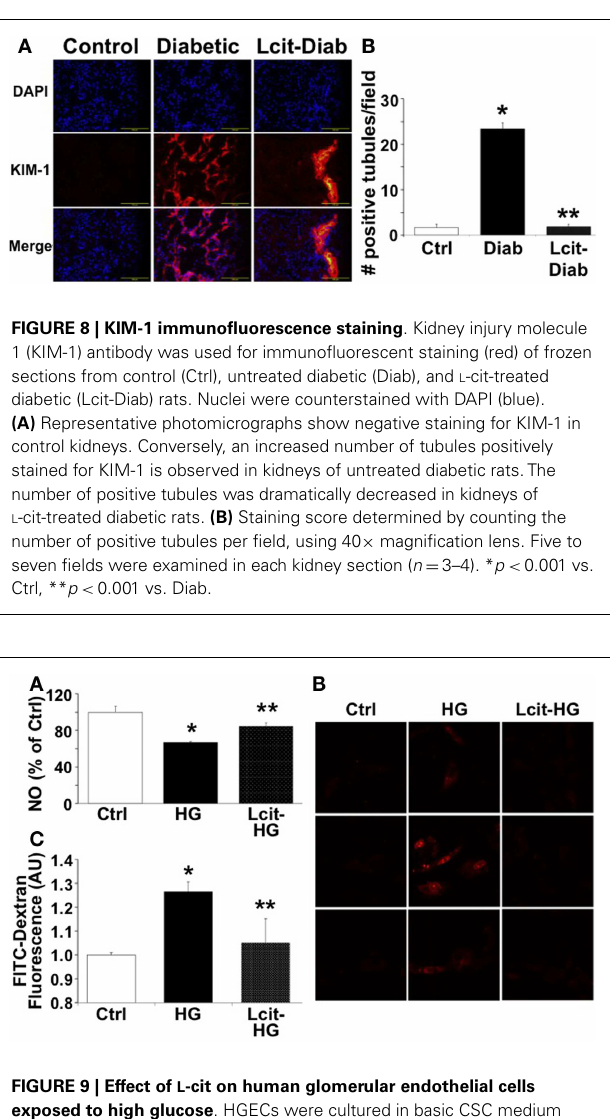
FIGURE 9 | Effect of L -cit on human glomerular endothelial cells exposed to high glucose . HGECs were cultured in basic CSC medium containing 25mM D -glucose (HG) with or without 1M L -cit for 24h (A,B) or 14days (C) . L -Glucose (19.5mM) was added to 5.5mM D -glucose present in basic CSC medium, and used as iso-osmotic control (Ctrl). (A) The nitrite level (picomole) in the medium was determined by NO analyzer and expressed as percent of control (* p < 0.01 vs. Ctrl, ** p < 0.05 vs. HG, n = 3). (B) HGECs were seeded onto gelatin-coated slide chambers. After completion of treatments, MitoSOX (a marker of mitochondrial superoxide, 5.0 µ M) was added to the cells and incubated further for 10min. Cells were washed and used for confocal microscopy imaging. Representative images show increase in mitochondrial MitoSOX fluorescence following treatment with HG.This effect was markedly reduced by concurrent L -cit treatment. (C) Transendothelial passage of FITC-dextran was used to determine permeability of HGEC monolayer, seeded onto collagen-coatedTranswells. Fluorescent density of samples was analyzed on a paradigm microplate fluorometer (* p < 0.01 vs. Ctrl, ** p < 0.05 vs. HG, n =